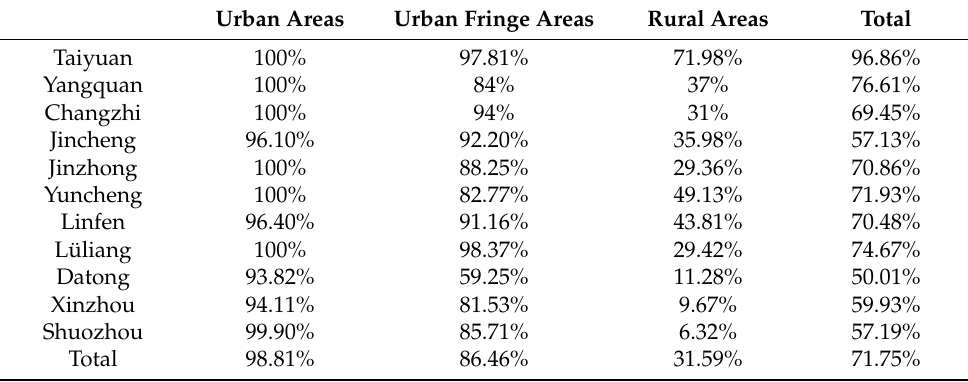
Table 7. 2018 Shanxi province’s 11 cities clean heating coverage